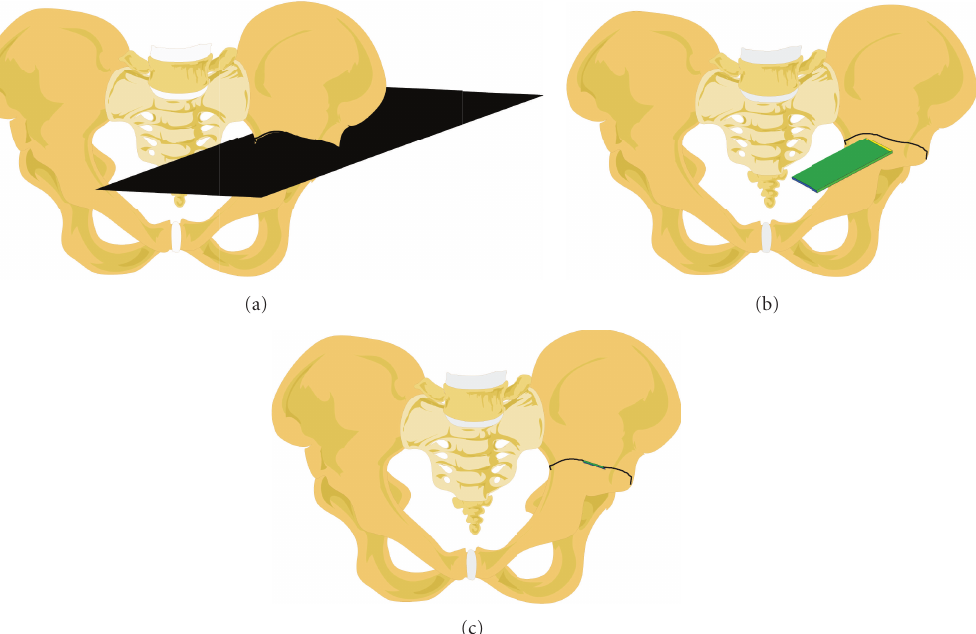
Figure 5: (a) Horizontal target plane horizontal above the acetabulum. (b) Only the intersection of the target plane with the pelvis is represented as a black line at the surface of the pelvis. The saw blade is visualized as a rectangle. The distal edge of the blade is represented by the yellow line and its proximal edge by a blue one. (c) When the saw blade is perfectly orientated into the resection plane, the three lines are perfectly